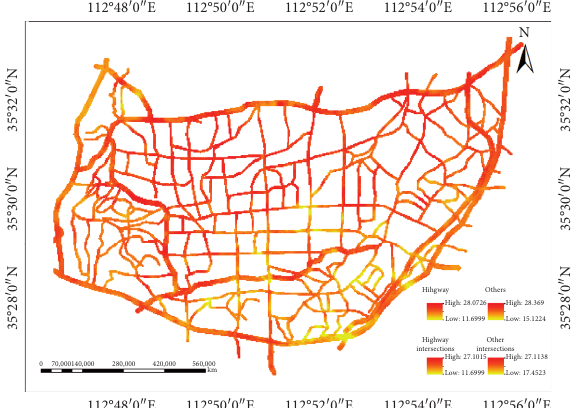
Figure 6. The fitting effect of the low LST increase and the